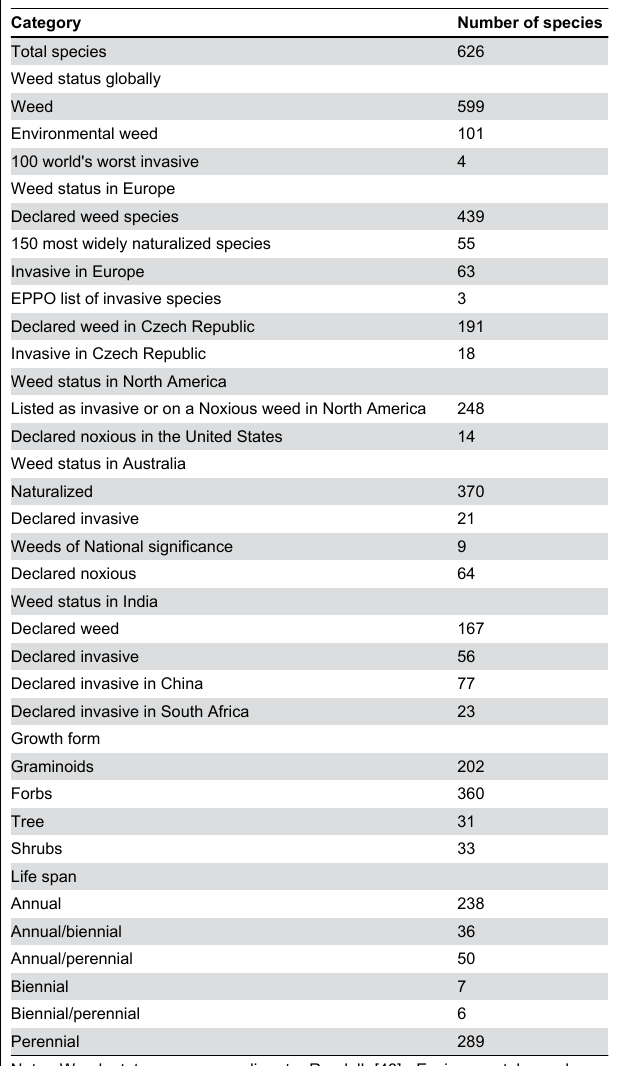
Table 2. Summary of the number of species with seed collected from cars, weed status globally, in Europe, Australia, North America, China, India and South Africa, their life forms and growth forms.